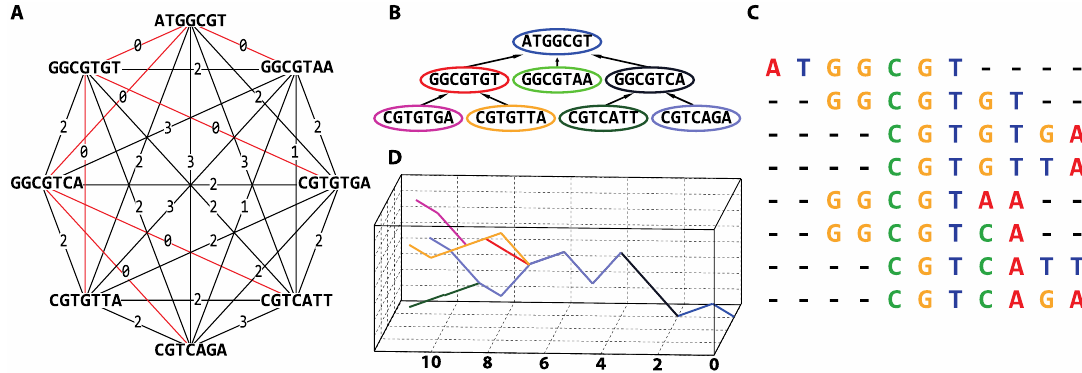
Figure 10. A de novo assembly methodology for numerically represented nucleotide reads. All-against-all sequence comparison ( A ) enables the construction of a read graph with weighted edges. The weight assigned to each edge is the smallest pairwise distance obtained between every possible k -mer representation of the two reads. In this example, a 5 -mer was used. The smallest distance between every possible k -mer can be obtained by either using a sliding window approach or break reads every possible subsequence with length k. ( B ) The shortest path in the graph is identified with a breadth-first search algorithm (red coloured edges) thereby ( C ) enabling read alignment. A DNA walk representation of the overlapped reads ( D ) may subsequently be used as a three-dimensional graphical portrayal of the reads, illustrating alignment characteristics.